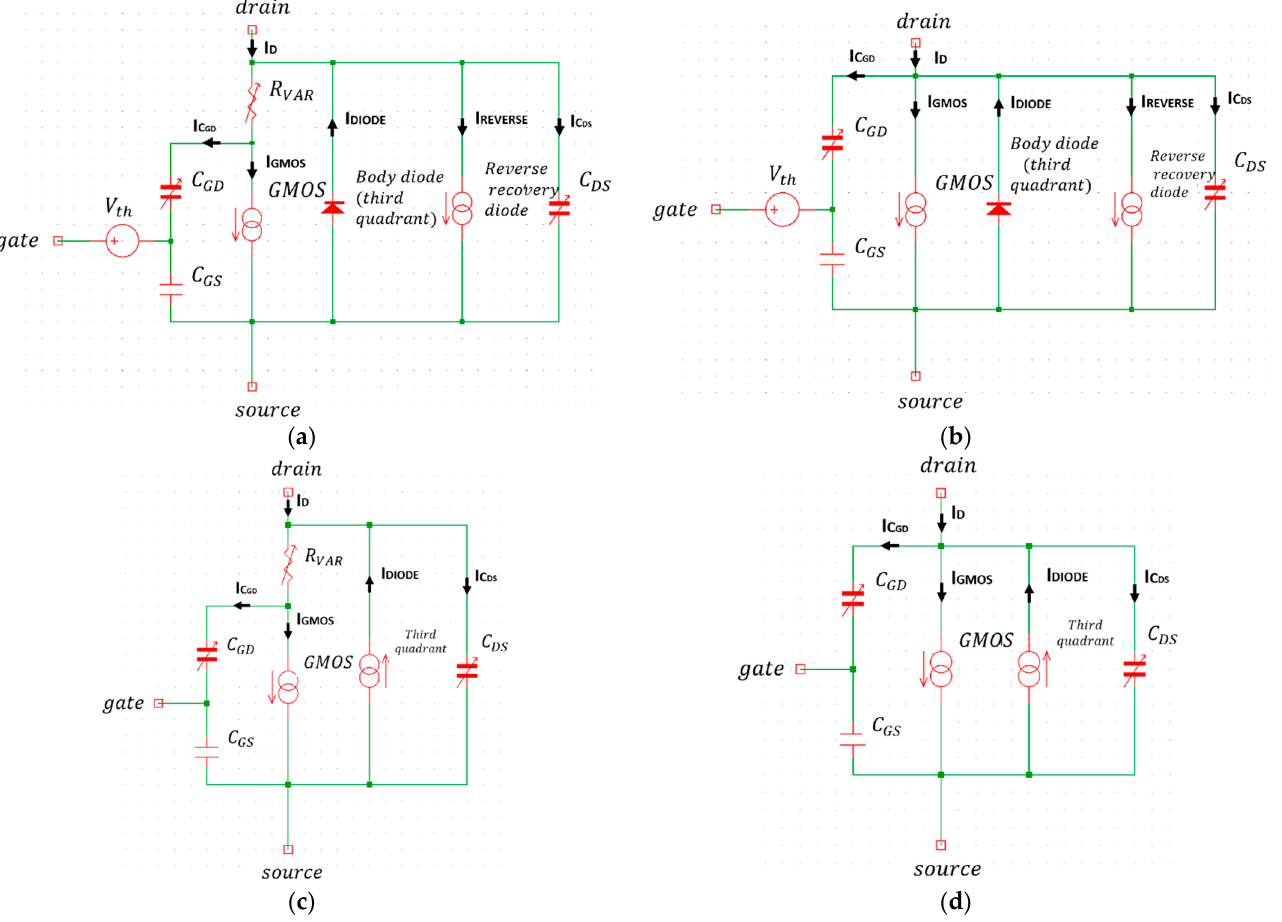
Figure 10. Generic behavioural models of power devices where, usually, the GMOS block mainly emulates the output and transfer characteristics; the Vth and the R VAR block emulate the variation of, respectively, the threshold voltage and the conduction resistance with temperature; the third quadrant block emulates the reverse conduction; the reverse recovery diode block emulates the reverse recovery current; C GS , C GD and C DS emulate the parasitic capacitances: ( a ) MOSFET with R VAR ; ( b ) MOSFET without R VAR ; ( c ) GaN HEMT with R VAR ; ( d ) GaN HEMT without R VAR .